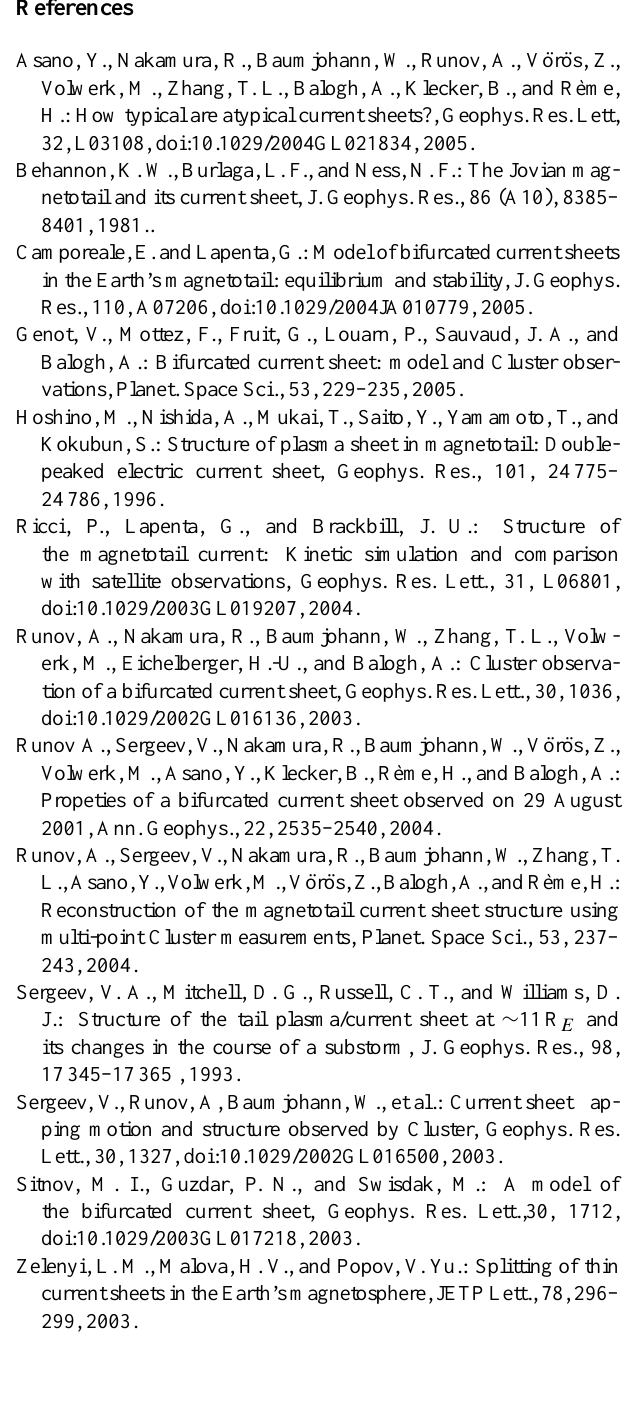
Fig. 3. Averaged < | dB x / dt | > depending on B x .